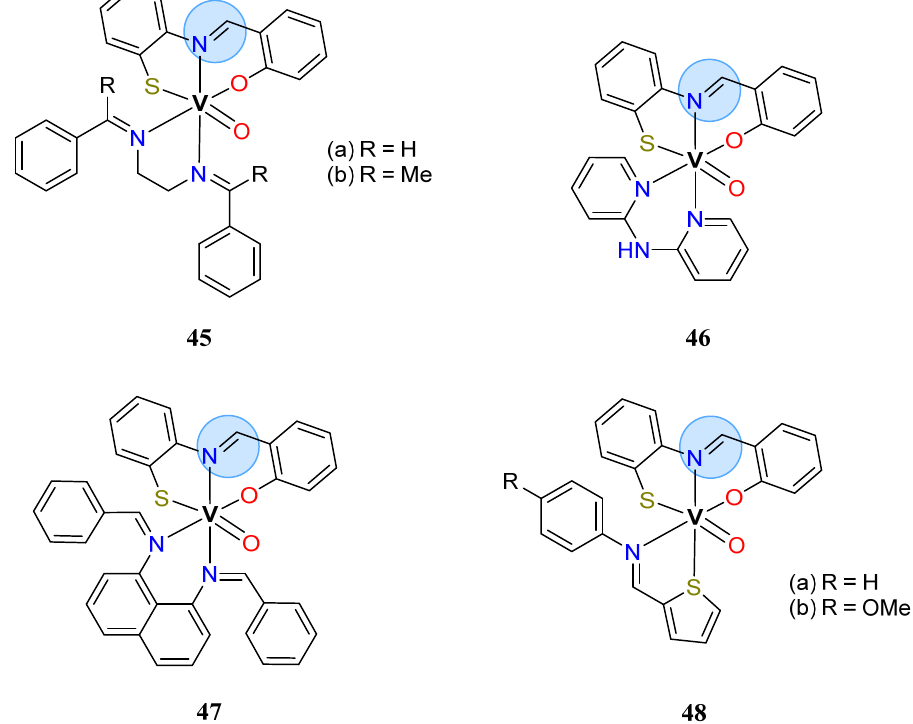
Figure 20. Oxovanadium(IV) complexes with Schiff bases SNO for antimicrobial activity.